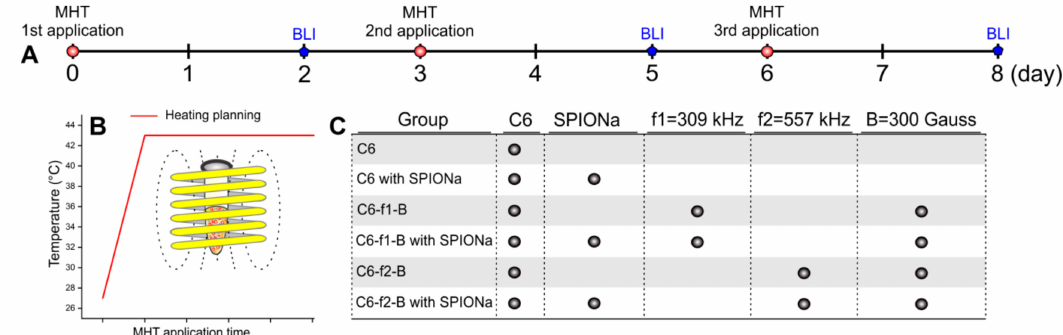
Figure 9. Experimental design of manifold applications of MHT in vitro. ( A ) Timeline with three MHT applications at 0, 3, and 6 days and their correspondent evaluation using BLI at 2, 5, and 8 days; ( B ) heating planning of the MHT process, keeping the constant temperature of 43 ◦ C; ( C ) experimental groups and their respective controls submitted to MHT therapeutic process with two combinations of magnetic field and oscillation frequencies of the AMF [(f1:309 kHz-B:300 Gauss); (f2:557 kHz-B:300